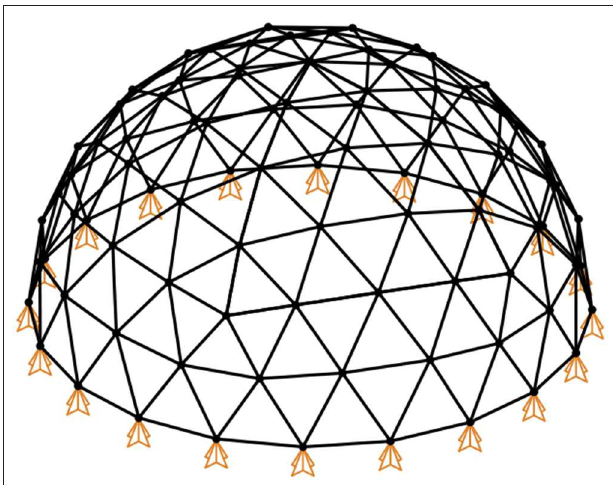
FIGURE 2 | The boundary conditions prevent all translations of the nodes at the base of the domes.